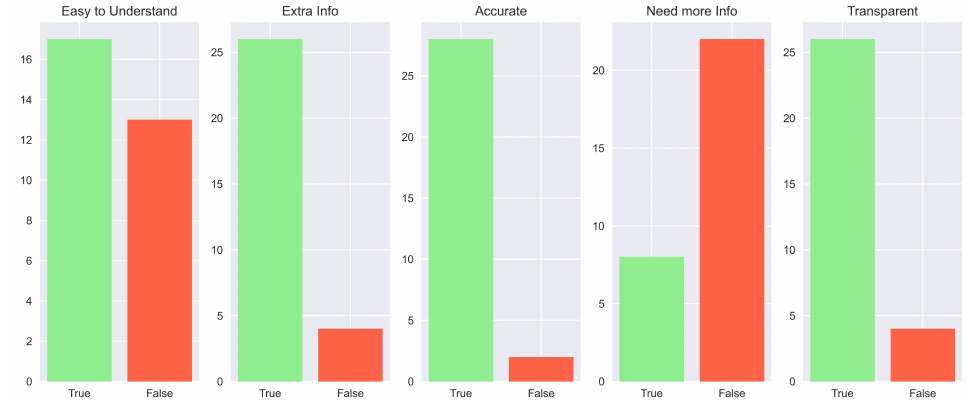
Figure 25. Bar charts representing the results of the True and False statements for different aspects of the counterfactual explanations.